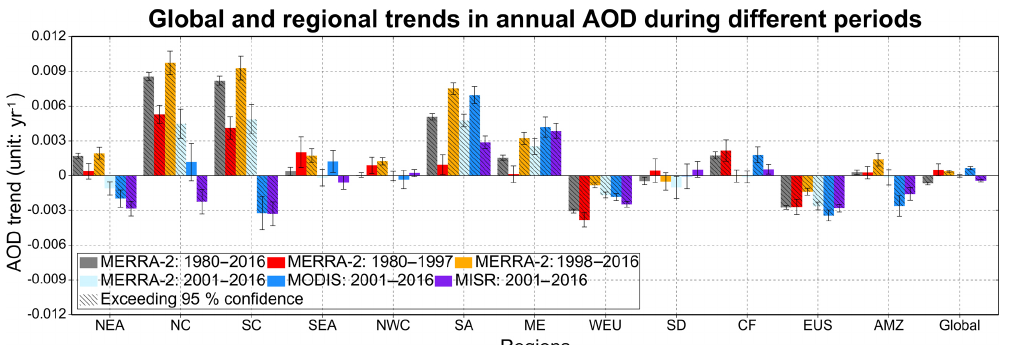
Figure 8. Intercomparisons of global and regional annual trends in AOD calculated from the time series value of the deseasonalized monthly anomaly of MERRA-2, MODIS/Terra and MISR, during the four periods of 1980–2016, 1980–1997, 1998–2016 and 2001–2016. Error bars represent the uncertainty associated with the calculated trend. The hatched trend bars indicate statistical significance at the 95% confidence